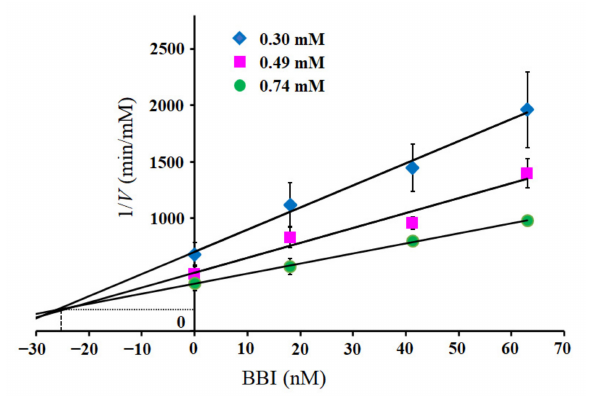
Figure 9. Dixon plots for the inhibition of DanMCsin with soybean Bowman–Birk inhibitor. Suc-Ala-Ala-Phe- p NA (0.30, 0.49, and 0.74 mM) was used as a substrate. Results are expressed as means ± SD of 3